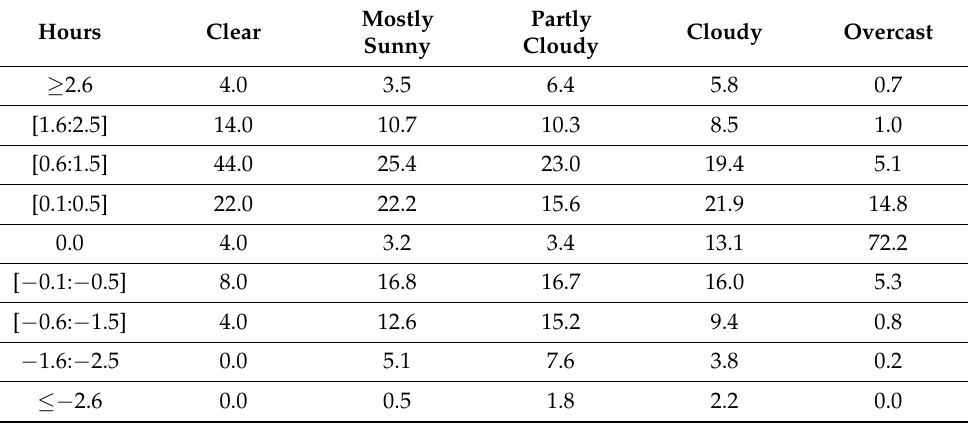
Table 6. Frequency [%] of daily differences in sunshine duration from manual and automatic measurements in various under various cloud cover in Borucino,